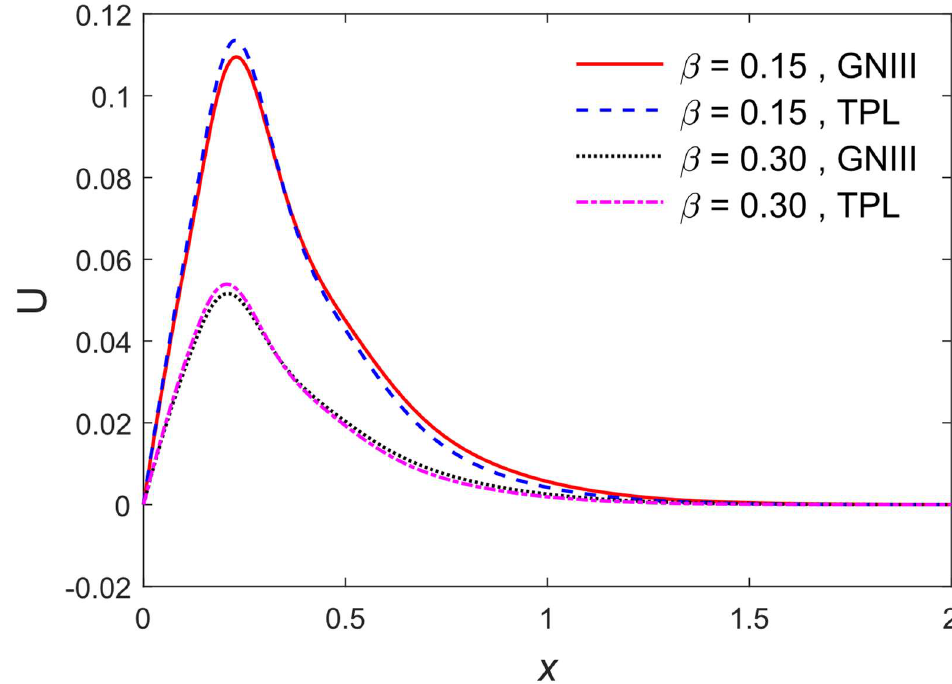
Figure 2. The distributions of solid displacement u along the distance x.